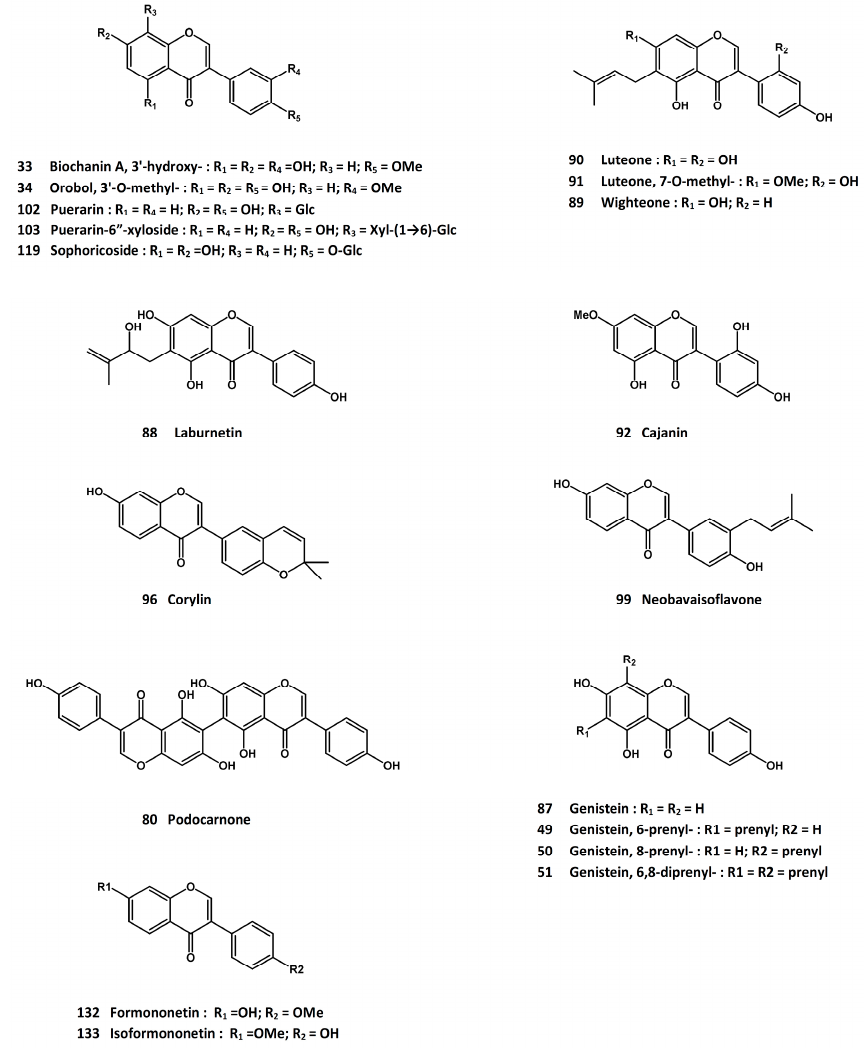
Figure 6. Isoflavonoids Reported to Possess Osteoprotective Property.